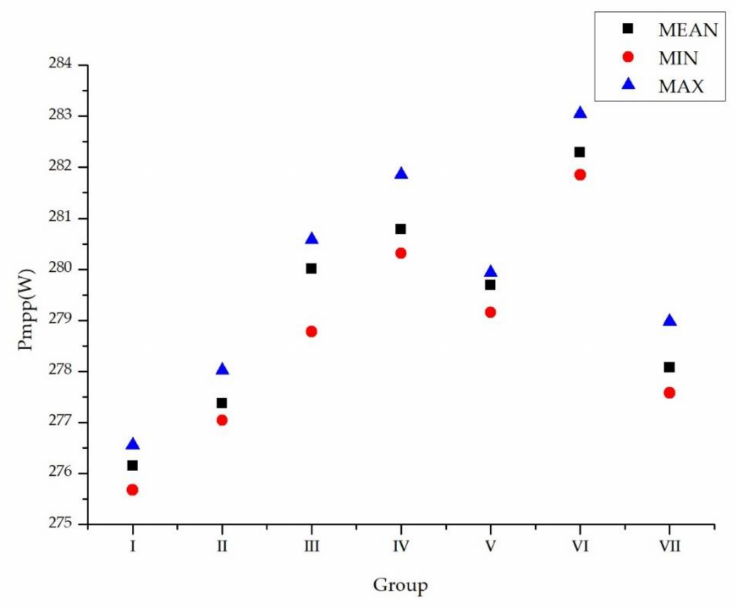
Figure 11. The output power of the seven